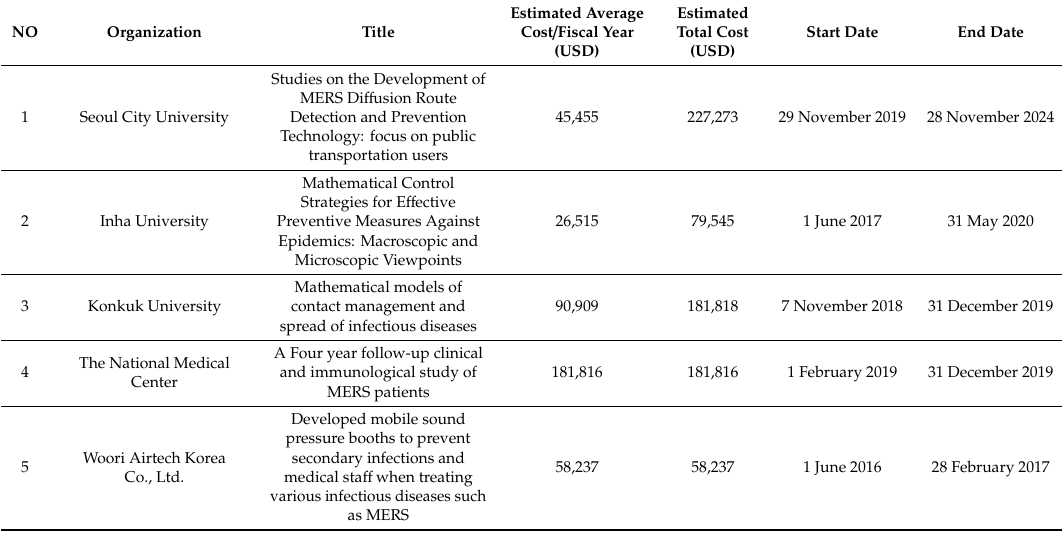
Table 13. Infectious disease epidemiological investigation and animal and environmental ecology in Korea (Cluster